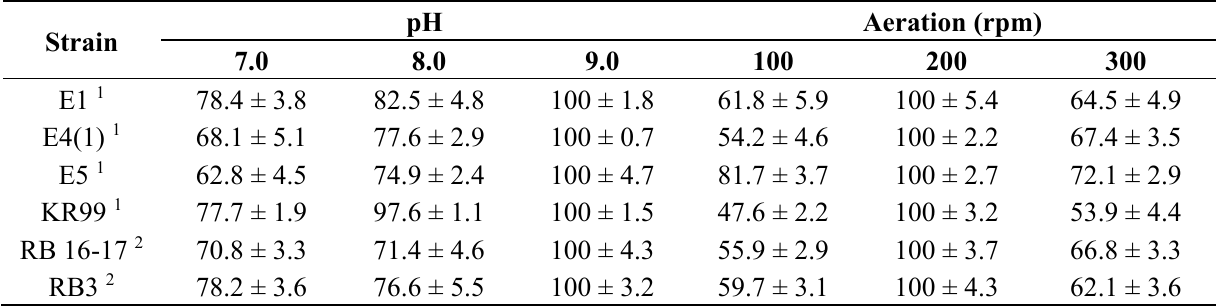
Table 1. Effect of pH and aeration on growth and reduction of K 2 TeO 3 estimated at A 950 over 96 h and represented as percent of maximal